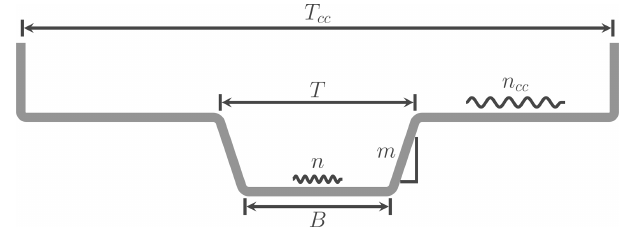
Figure 3. Schematic of the geometry and roughness parameters of the streamflow compound channel, with the top width ( T ), bottom width ( B ), side slope ( z ), Manning’s N ( n ), width of the compound channel ( T cc ), and Manning’s N of the compound channel ( n cc